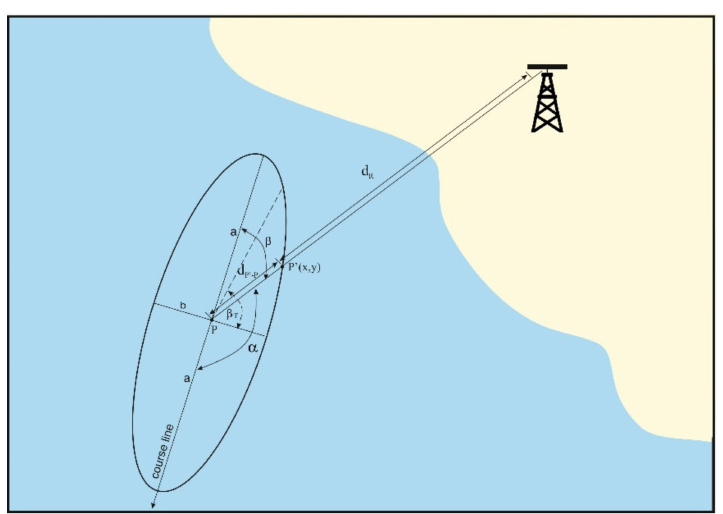
Figure 4. Measurement structure for the model when the radar beam hits the side of the vessel’s hull.